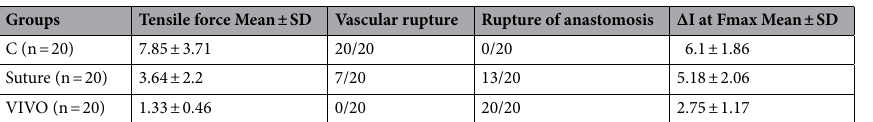
Table 3. Results of tensile strength determination.